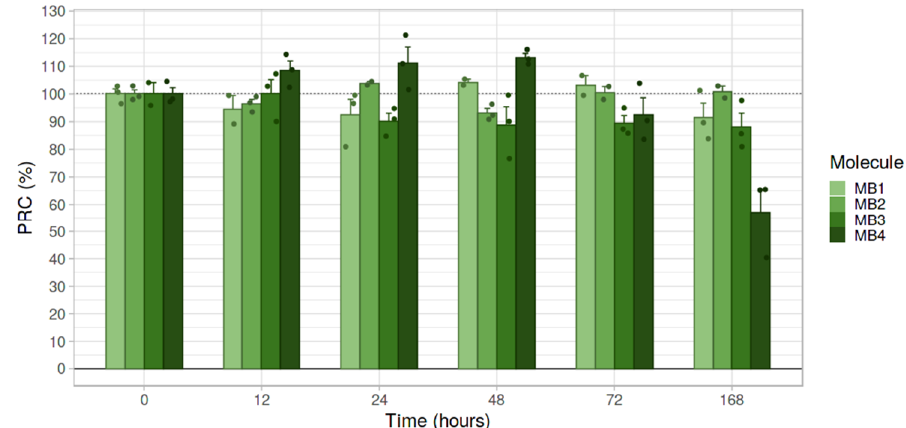
Figure 2. Evaluation of the stability of hydroxybenzoic-based mitochondriotropic antioxidants MB1-MB4 under indoor light conditions at room temperature for 168 hours (7 days), by measuring the percentage of remaining compound (PRC%) by UHPLC. Stock solutions of MB1-MB4 were prepared in DMSO at 4 mM and diluted in ultrapure water to achieve a final concentration of 100 μM. Data are the mean ± standard error (SE) of three independent experiments. Results are expressed as the percentage of concentration in predetermined time-points compared with initial concentration solutions (t = 0 min).